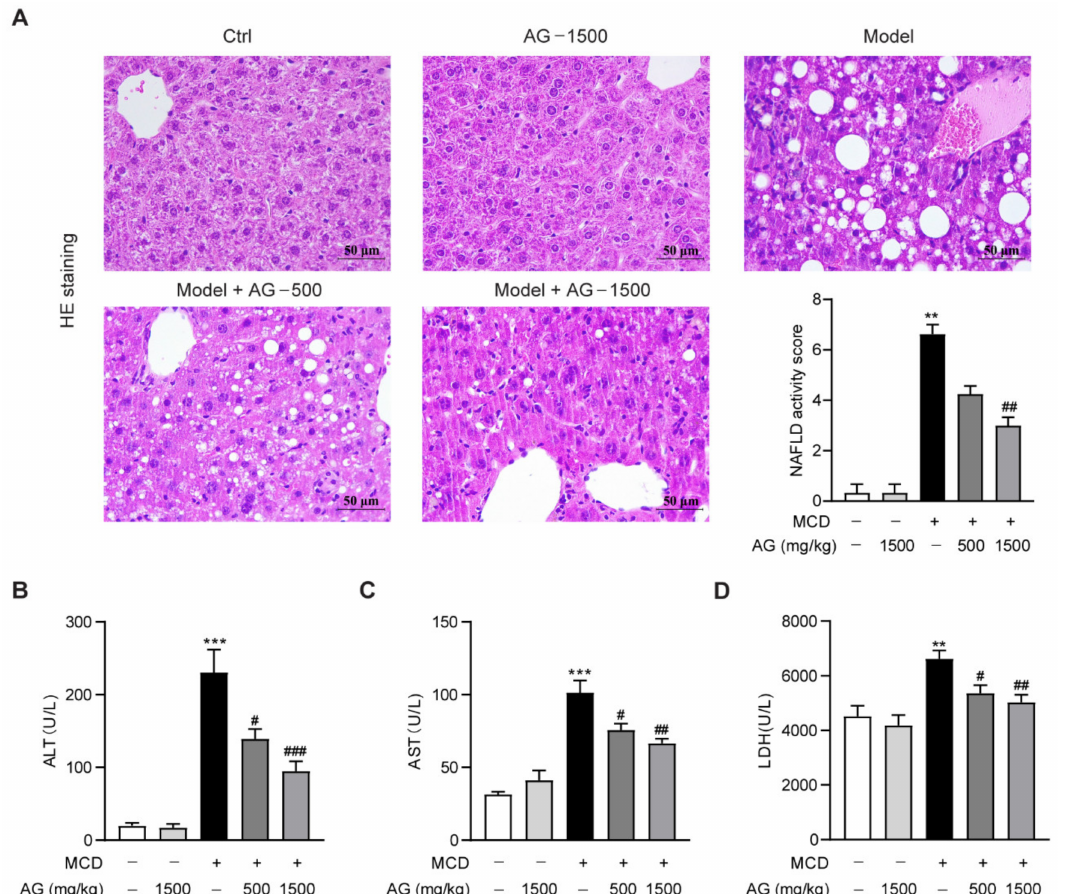
Figure 1. Ala-Gln alleviated steatohepatitis in MCD-fed mice. ( A ) Hematoxylin and eosin (HE) staining ( × 400) images in liver tissues; quantification of NAFLD activity score. ( B ) Plasma ALT levels. ( C ) Plasma AST levels. ( D ) Plasma LDH levels. Data are expressed as the mean ± SEM. ** p < 0.01, *** p < 0.001, compared to the Ctrl group; # p < 0.05, ## p < 0.01, ### p < 0.001, compared to the Model